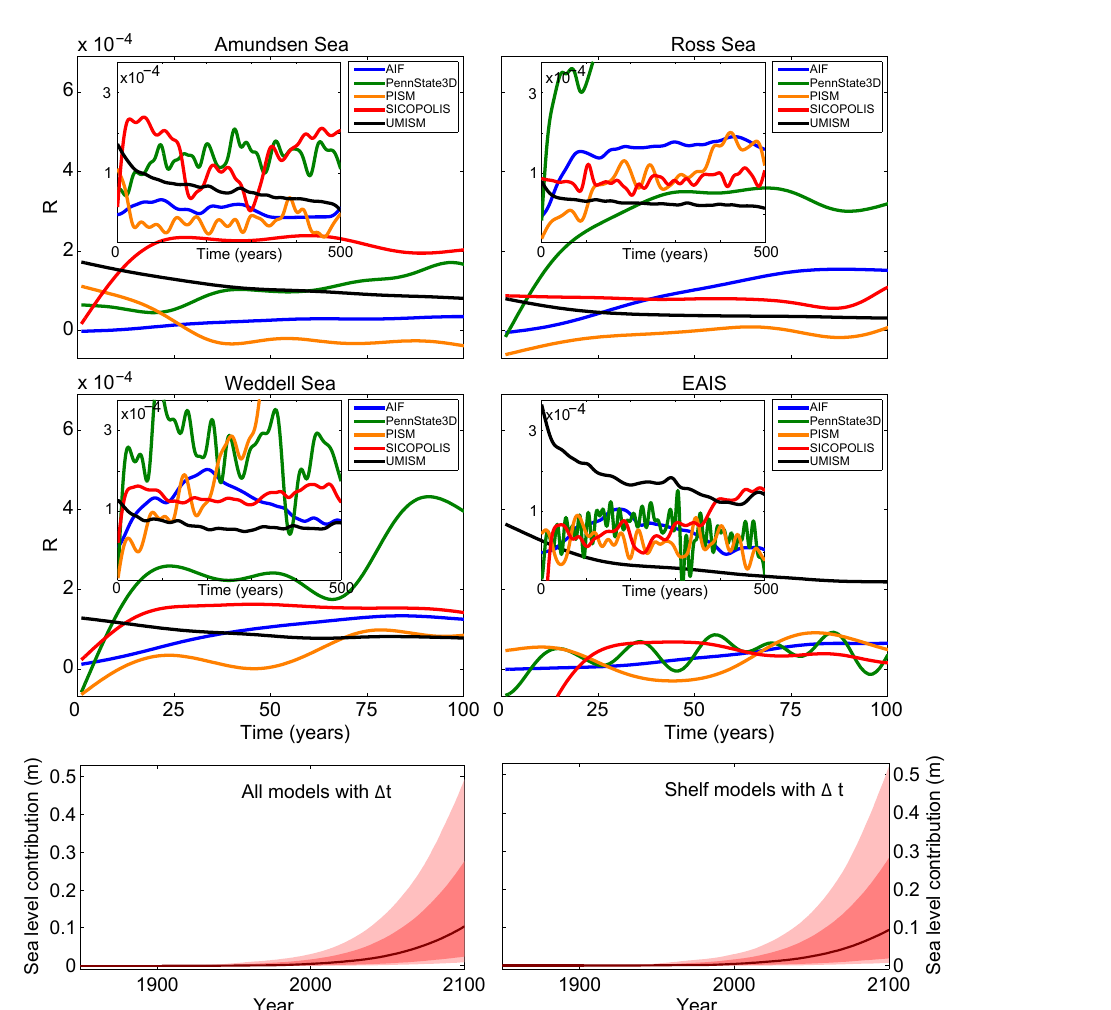
Figure 14. Response functions as obtained from the M1 experiment of the SeaRISE intercomparison with an additional uniform basal ice-shelf melting of 2ma − 1 . The upper four panels correspond to Fig. 3. The lower two panels show the uncertainty range in sea-level projections with the M1 response functions from above. The ranges obtained are very similar to the ranges obtained with the M2 response functions as shown in Fig. 11. While the response functions are very different for the M1 experiment compared to the M2 experiment, the projected ranges of sea-level rise are similar which is consistent with the fact that the uncertainty arises mainly from the uncertainty in the external forcing of the ice